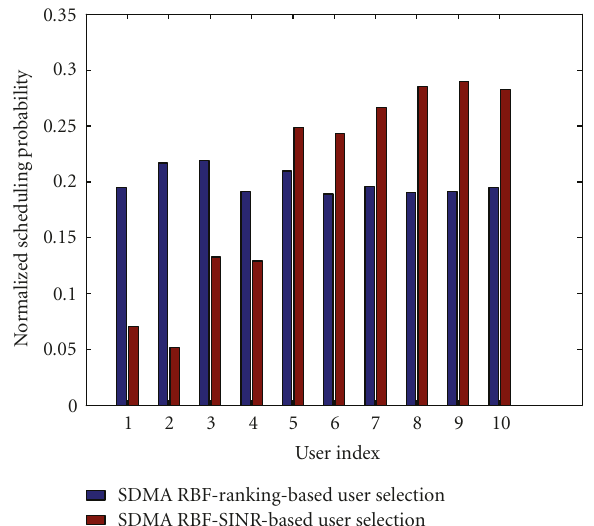
Figure 8: Normalized scheduling probability versus user index for multibeam RBF with M = 4 antennas and K = 10 users. The users are sorted from the lowest to the highest average signal-to- noise ratio (SNR) and the signal-to-noise ratio (SNR) range is from − 10dB to 30 dB. The probability of selection is equalized among users when ranking-based CQI instead of SINR feedback is